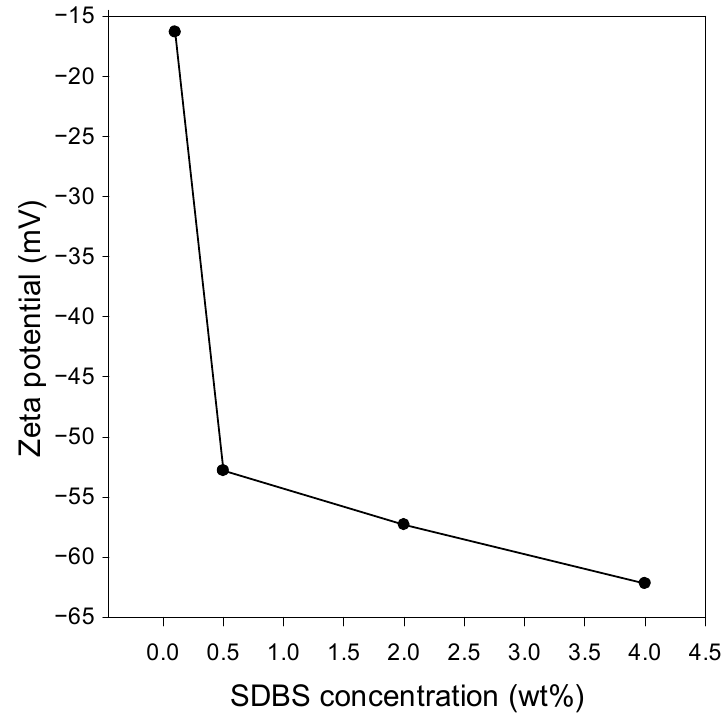
Figure 2. Zeta potential values of the formulated crude oil/water nanoemulsions at different con- centrations of the emulsifier (i.e., SDBS).